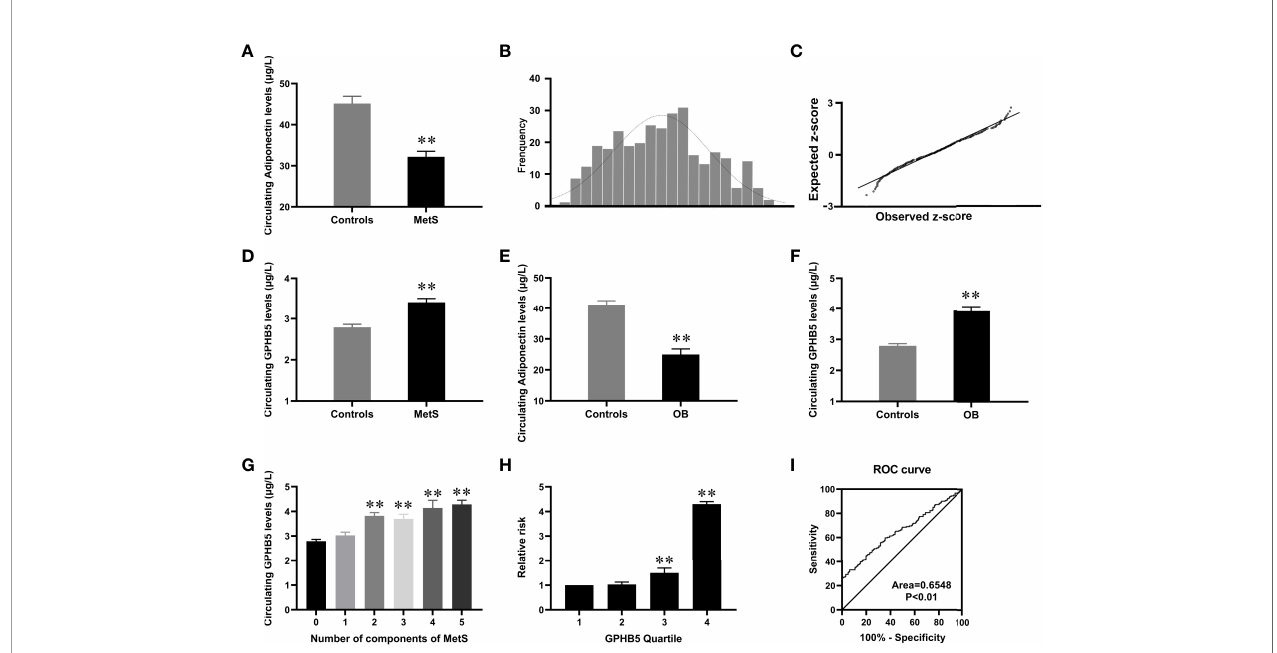
FIGURE 3 | Circulating GPHB5 levels in the study population. (A) Circulating Adiponectin levels in healthy and MetS individuals. (B) Distribution of GPHB5 levels in healthy population. (C) Q-Q plot of normalized residuals versus a normal distribution. (D) Circulating GPHB5 levels in healthy and MetS individuals. (E) Circulating Adiponectin levels in lean and O/B individuals. (F) Circulating GPHB5 levels in lean and O/B individuals. (G) Circulating GPHB5 levels in relation to the number of MetS components. (H) The odds ratio of having MetS in different tertiles of circulating GPHB5. (I) ROC curve analysis of the prediction of MetS. O/B, overweight/